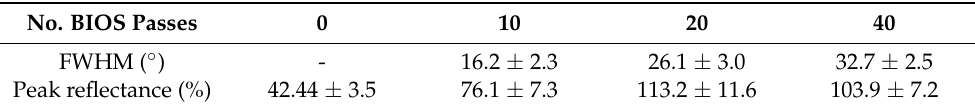
Table 1. Full width half maxima of scattering cones as a function of BIOS passes, determined from a Gaussian fit of the maximum intensities at each measured angle for each sample. It was not possible to determine this value for 0 BIOS with accuracy. The peak intensity was recorded for these